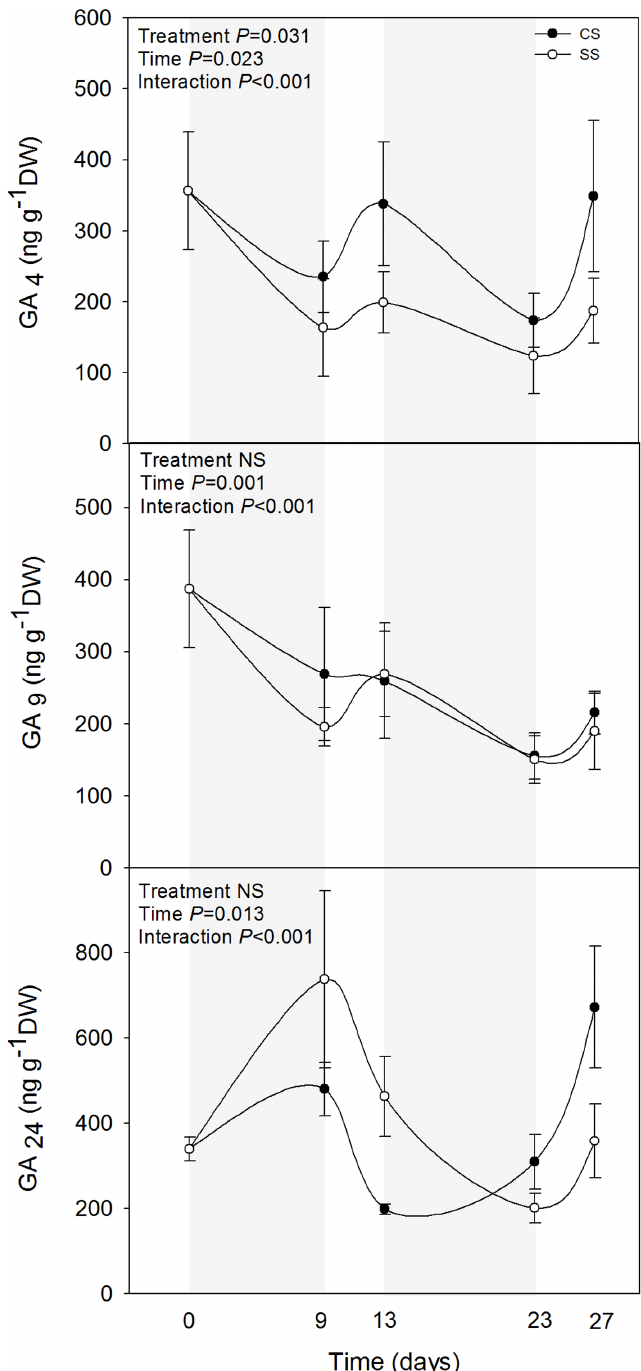
Fig 2. Endogenous concentrations of gibberellin 4 (GA 4 ), and its precursors, gibberellin 9 (GA 9 ) and gibberellin 24 (GA 24 ) in leaves of A . cordifolia . Data represent the mean ± SE of n = 7 individuals. Significant differences between groups were tested by two-way analysis of variance (ANOVA) and Duncan posthoc